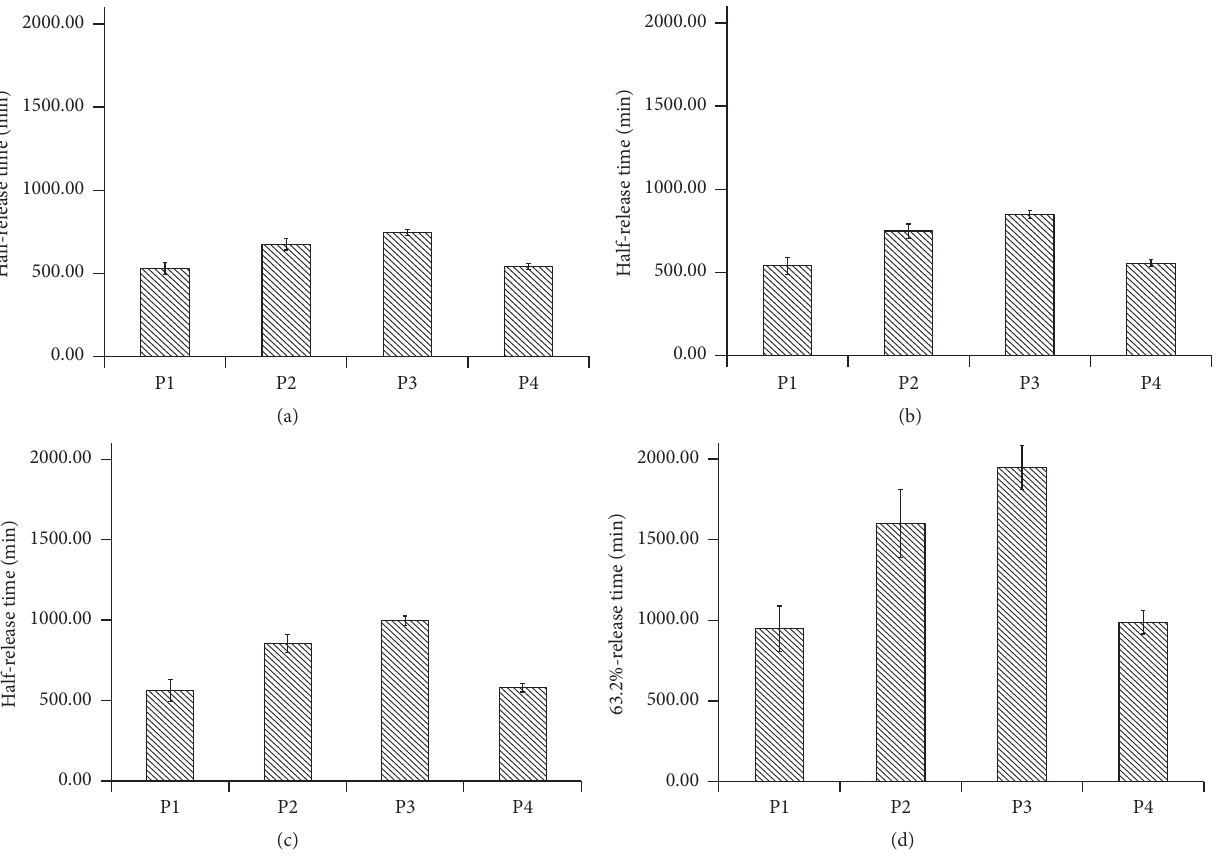
Figure 5: Histograms of half-release times and 63.2%-release time of EH for various hydrogels prepared with the use of MC (P1), PA1 (P2), PC-11 (P3), and PA2 (P4), evaluated according to the kinetics models: (a) zero-order kinetic equation, (b) first-order kinetic equation, (c) second-order kinetic equation, and (d) Weibull model; the Y-bar represents SD; 𝑛 = 6 .